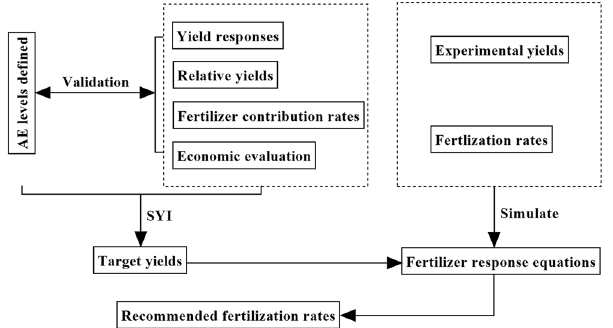
Figure 5. Framework of the new fertilizer recommendation method based on agronomic efficiency (AE) and sustainable yield index